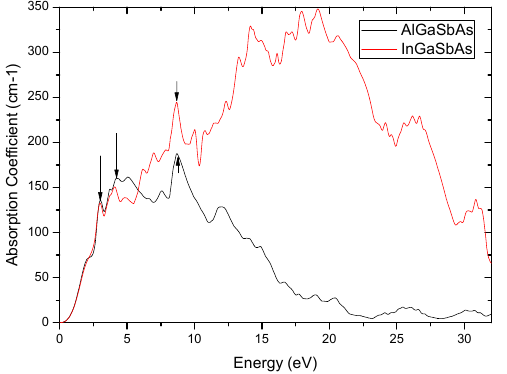
Figure 10. Absorption coefficient (essential parameter for TPVSs) of In 0.125 Ga 0.875 SbAs compared to that of the nanostructured Al 0.125 Ga 0.875 Sb 0.75 As 0.25 .